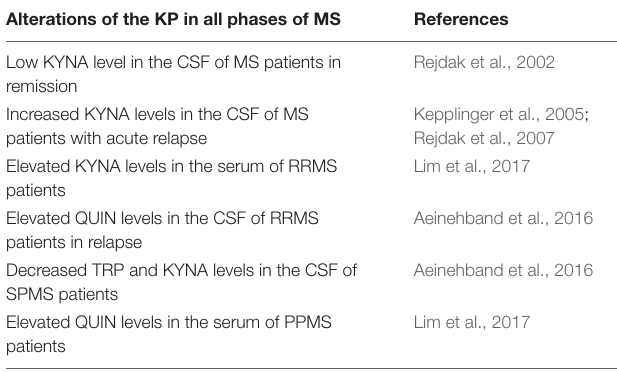
TABLE 1 | The role of kynurenine metabolites of